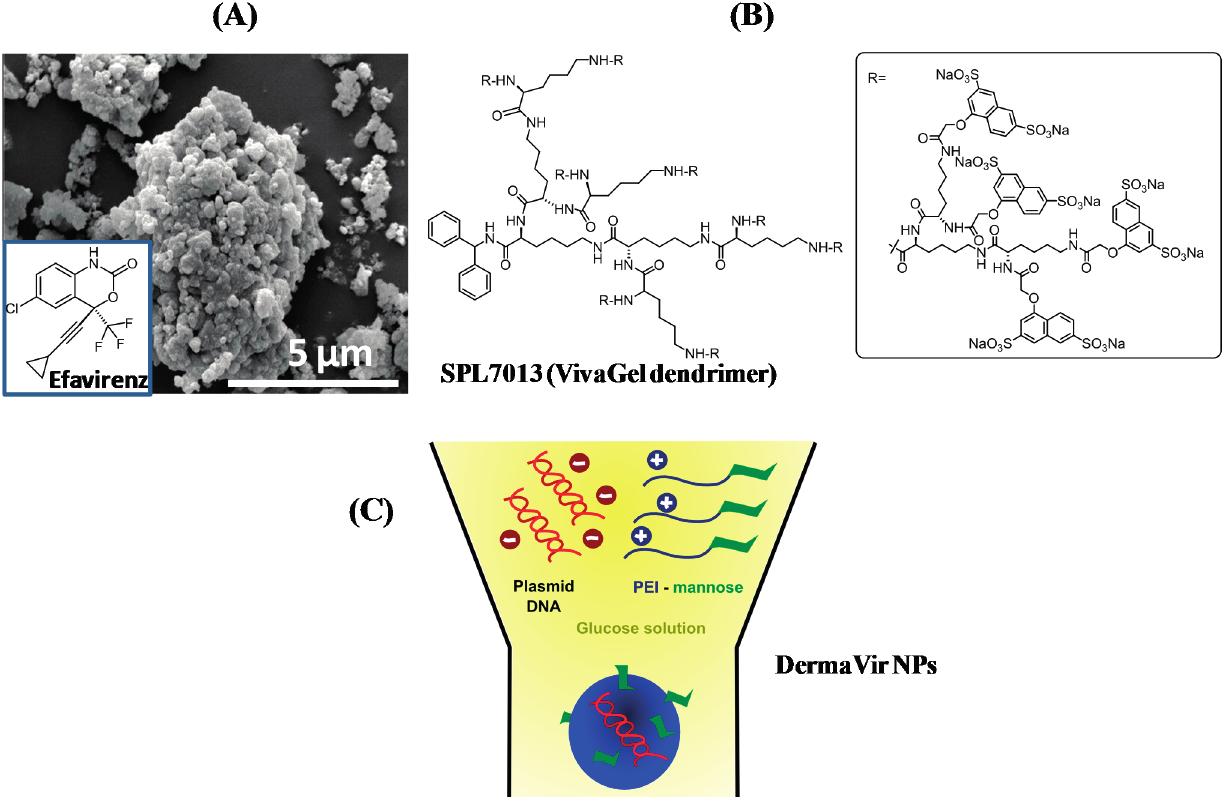
Figure 4. ( A ) SEM image of efavirenz-loaded albumin nanoparticles (reprint with permission from Ref. [57]); ( B ) Chemical structure of VivaGel (SPL 7013) dendrimer; ( C ) Chemical formulation of DermaVir and administration